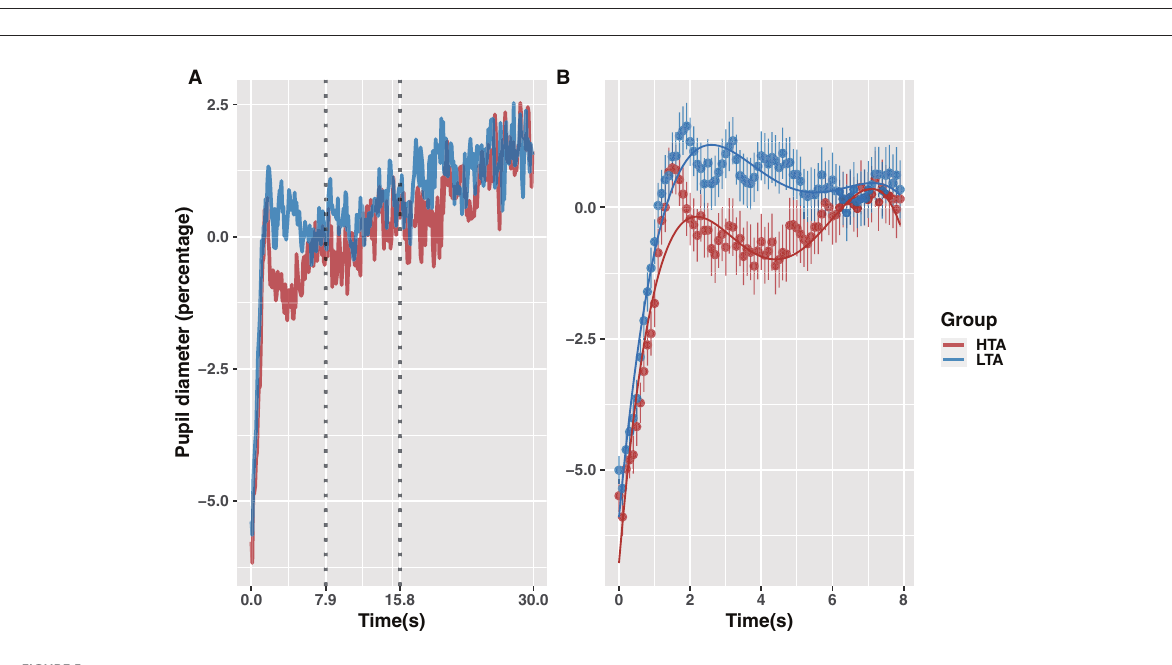
FIGURE4 GCA model fits of the gaze data on emotional stimuli for the HTA and LTA groups in 0–7.9s period (A) , 7.9–17.7s period (B) and 17.7–30.0s period (C) .